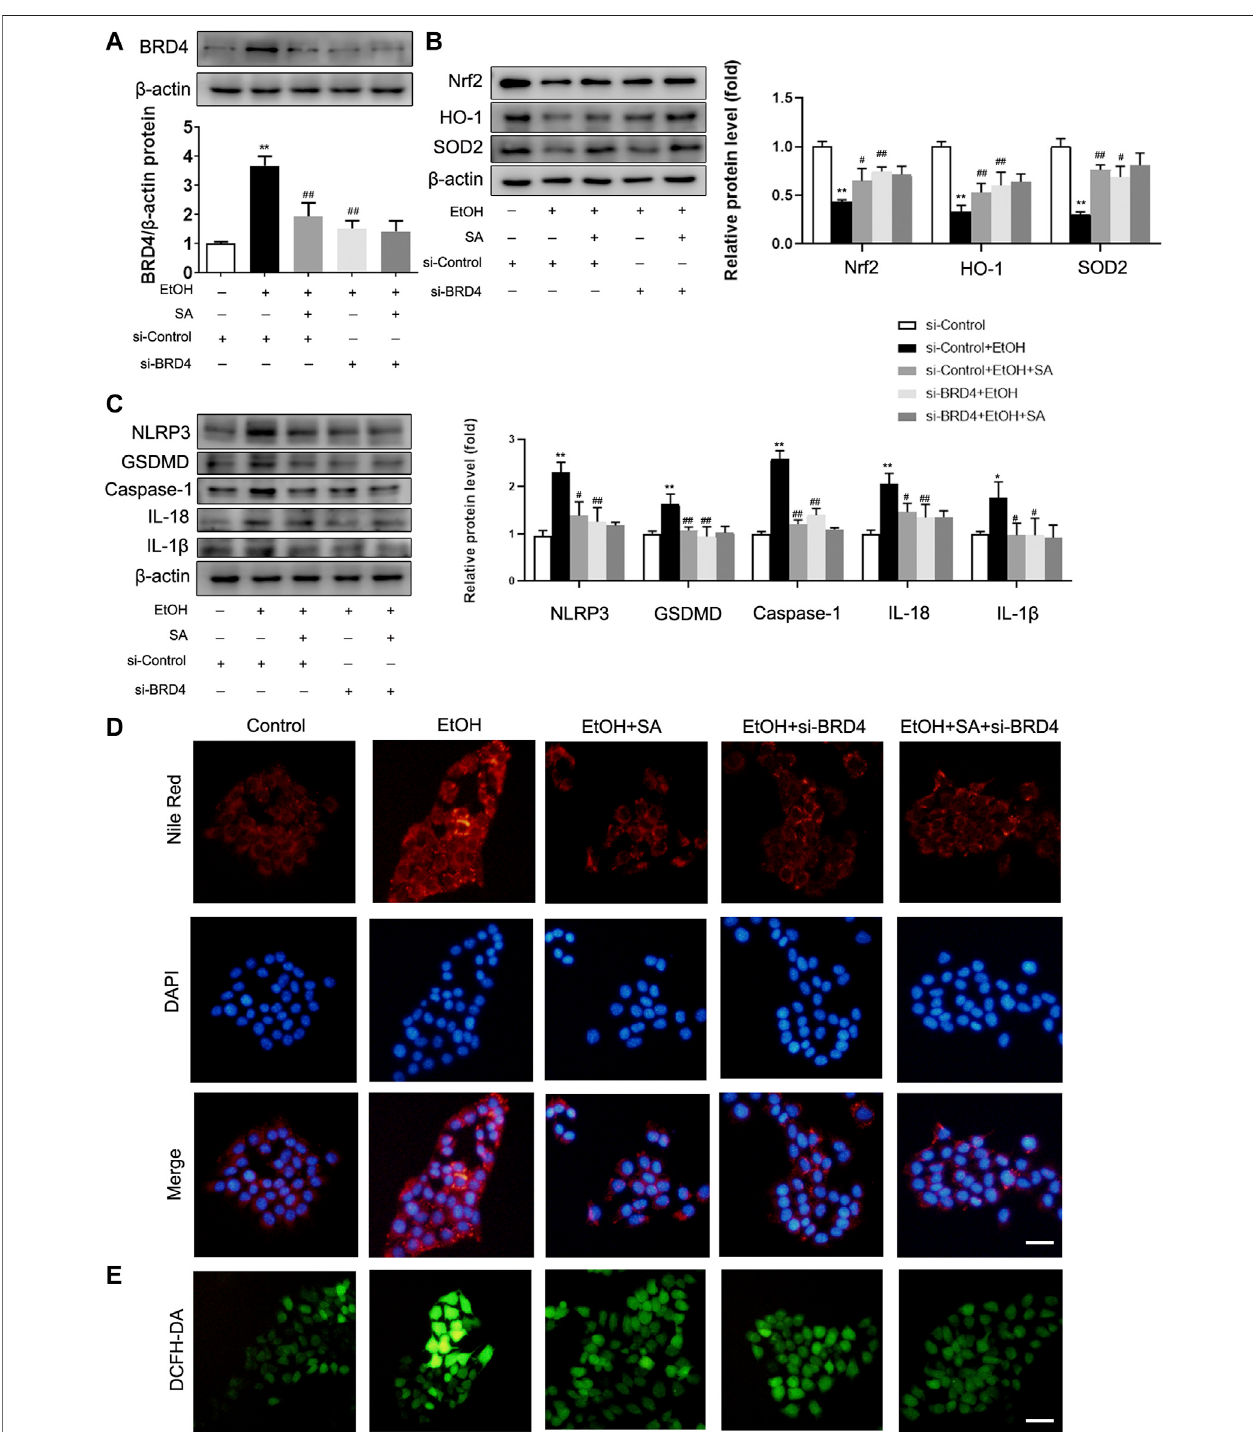
FIGURE 5 | SA ameliorates oxidative stress, pyroptosis and reduces lipid accumulation in EtOH-treated AML-12 cells by regulating BRD4. (A) AML-12 cells were transfectedwithBRD4siRNAorcontrolsiRNAfor24 h,20 μ M SAfor6 h,beforeexposuretoEtOH(100 mM)for24 hornot.ExpressionofBRD4wasmeasured invitro ( n (cid:2) 3). (B) Western blotting ofNrf2, HO-1, and SOD2 levels ( n (cid:2) 3). (C) Western blotting of NLRP3, GSDMD, activated caspase-1, IL-18 and IL-1 β protein levels ( n (cid:2) 3). * p < 0.05, ** p < 0.01 vs the control group; # p < 0.05, ## p < 0.01 vs the EtOH group. (D) Intracellular lipid accumulation was measured by Nile Red staining ( × 200). Scale bar (cid:2) 50 μ m. (E) DCFH-DA staining ( × 200). Scale bar (cid:2) 50 μ m.